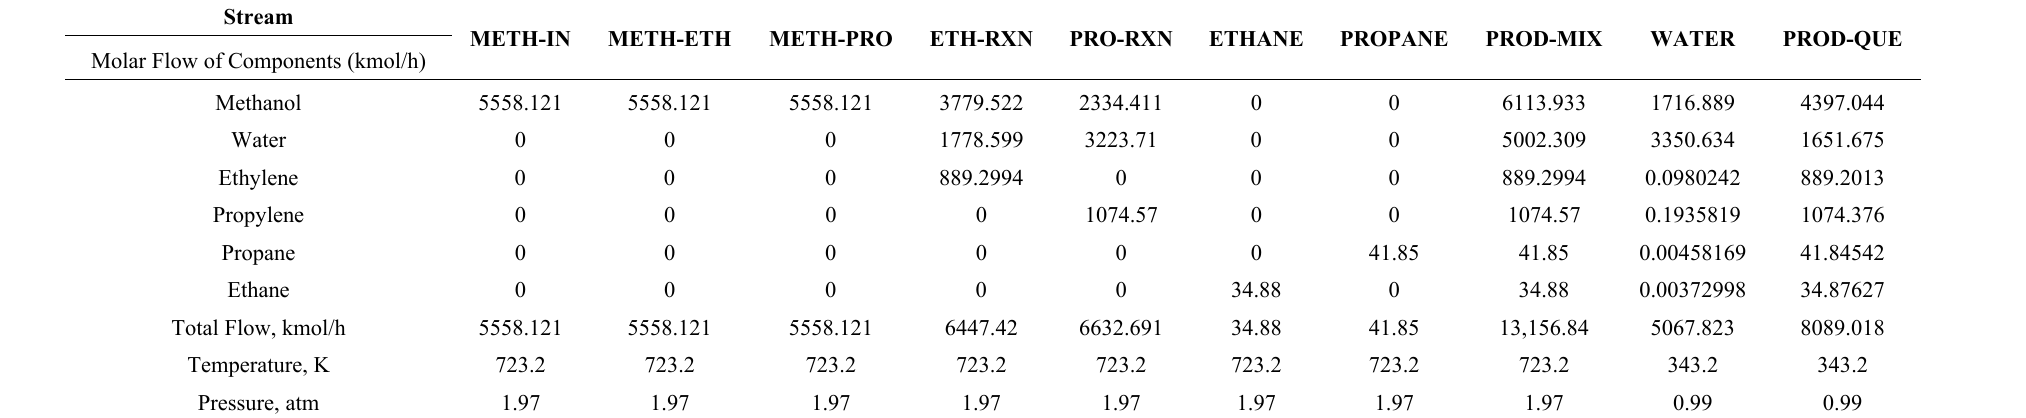
Figure A2. The ASPEN Plus Simulation Flowsheet for the MTP Process. Table A1. The stream data for the methanol to olefins (MTO)